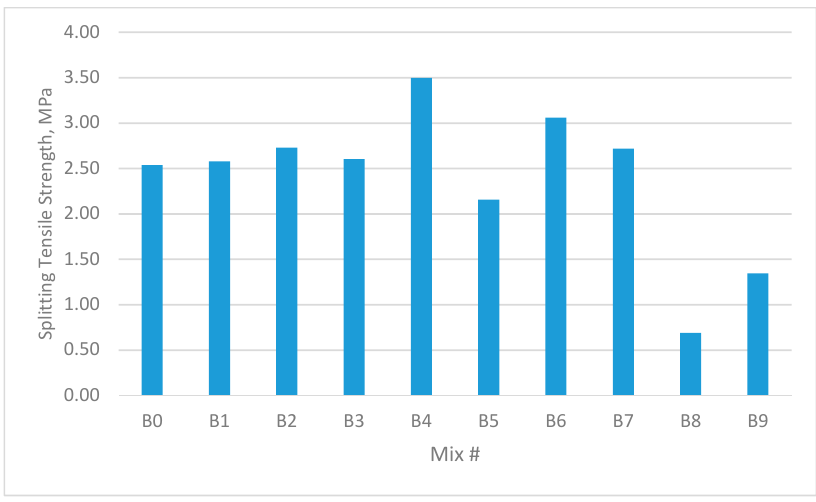
Figure 9. Splitting tensile strength of concrete beams with W/B ratio 0.35.